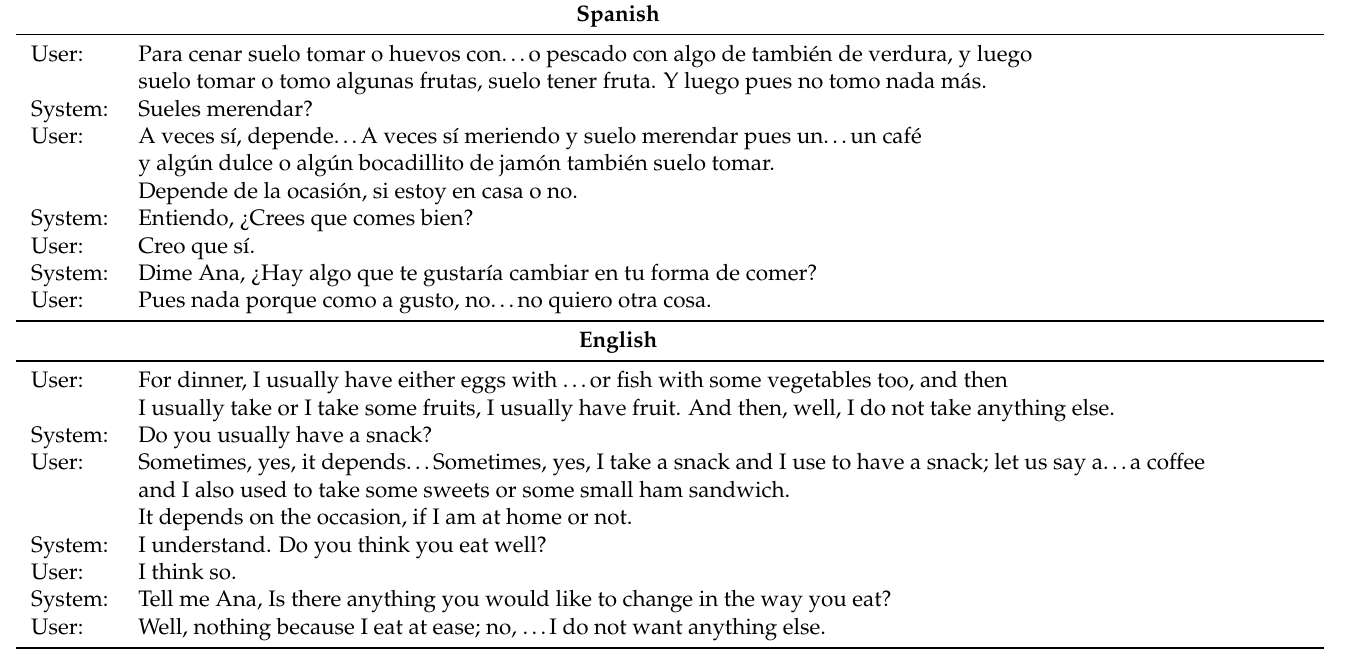
Table 2. Small excerpt taken from the Empathic VA corpus. This sample is a segment of a conversation between a user and the WoZ. It shows that the WoZ generally asks questions and tries to obtain extensive answers from the user. The excerpt is shown in Spanish (original language) above and then in English (translation)